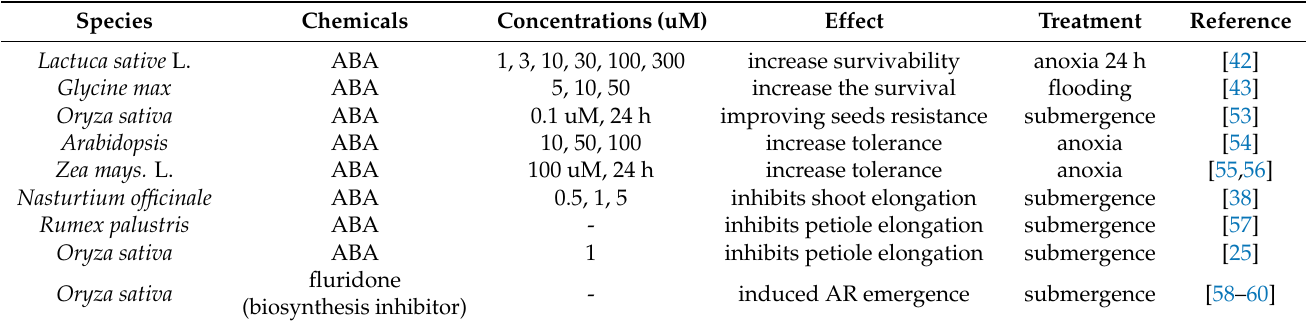
Table 2. The effect of ABA on flooding stress in different plant